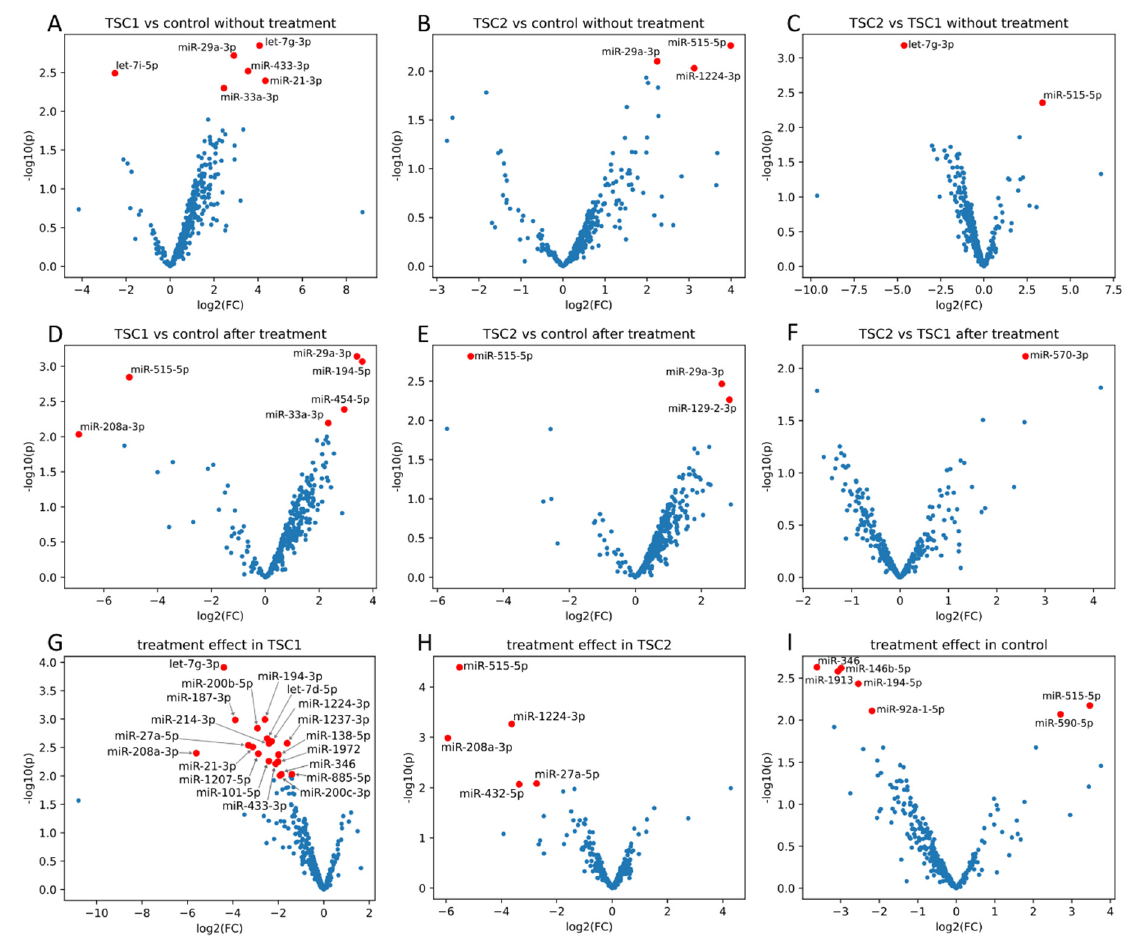
Figure 1. Differences in miRNA expression between TSC1 defect and control ( A ), TSC2 defect and control ( B ), and TSC1 and TSC2 defect ( C ), without rapamycin treatment and after rapamycin treatment ( D , E , F , respectively). Effect of rapamycin treatment on miRnome in TSC1 ( G ), TSC2 ( H ) and control ( I ). All fold changes (FC) and p -values from limma (Supplementary Files 3–11). Red marks denote miRNAs with p values <0.01.